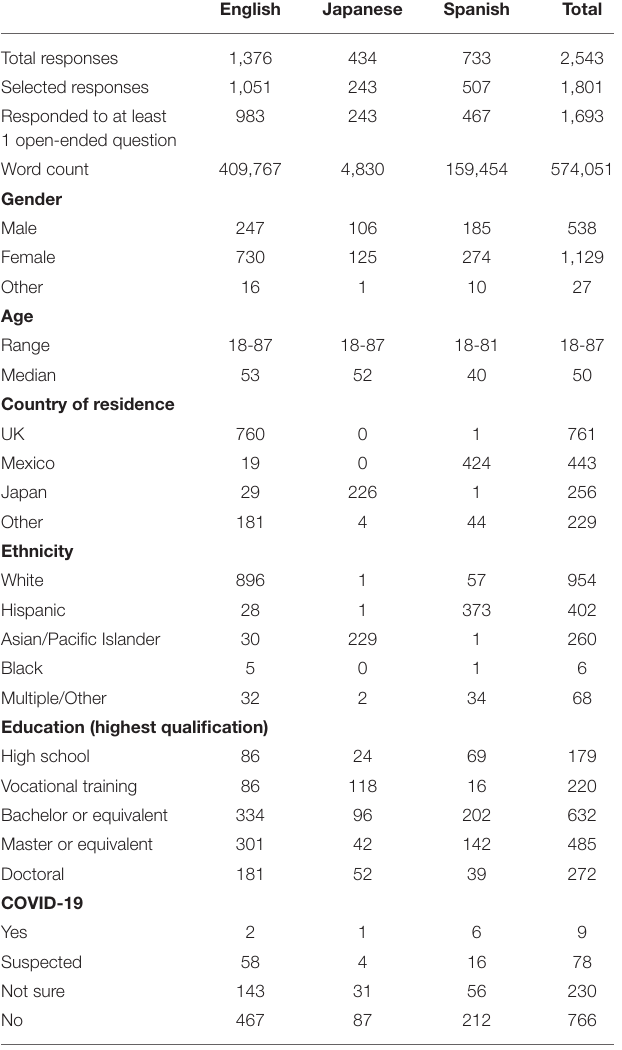
TABLE 1 | Statistics and demographics of the Pandemic Experience